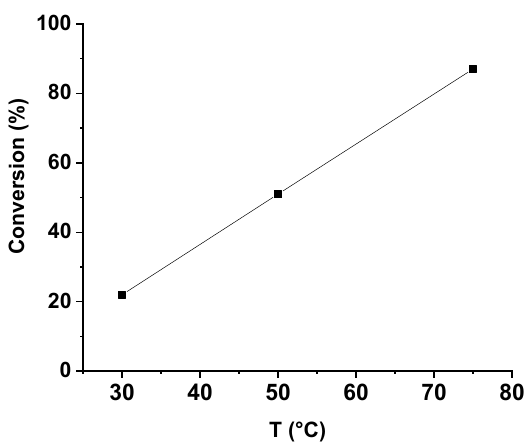
Figure 2. Thermal dependence of conversion, using LaCoODA as catalyst.